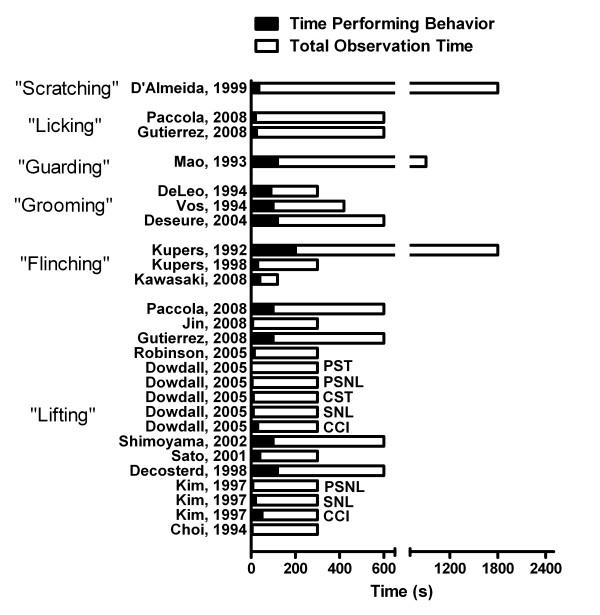
Frequency of proposed behaviors indicating chronic spontaneous pain in the neuropathic pain literature. Bars indicate total duration (s) of the behavior (filled) and total observation time (open). All studies used surgical nerve injuries, which are not noted except in studies featuring multiple surgeries. Note that the "scratching" behavior quantified by D'Almeida et al. [16], first described in Kupers et al. [18], is defined as "a rapid vibration of the hind paw," and is probably analogous to what is defined herein as shaking/flinching. Abbreviations: CCI, chronic constriction injury; CST, complete sciatic transection; PSNL, partial sciatic nerve ligation; PST, partial sciatic transection; SNL, spinal nerve ligation. References (from top; only first author noted): D'Almeida, 1999 [16], Paccola, 2008 [61], Guttierez, 2008 [62], Mao, 1993 [63], DeLeo, 1994 [64], Vos, 1994 [65], Deseure, 2004 [66], Kupers, 1992 [67], Kupers, 1998 [18], Kawasaki, 2008 [12], Jin, 2008 [68], Robinson, 2005 [69], Dowdall, 2005 [53], Shimoyama, 2002 [70], Sato, 2001 [71], Decosterd, 1998 [72], Kim, 1997 [52], and Choi, 1994 [73].